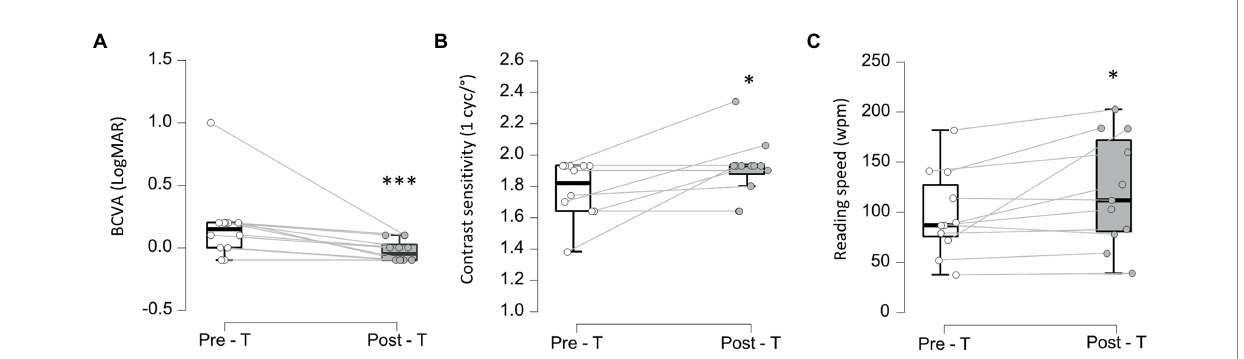
FIGURE 3 Visual acuity, contrast sensitivity and reding speed. (A-C) Pre (Pre-T) and post-treatment (Post-T) measures of visual acuity using Best Corrected Visual Acuity (BCVA) (A) ***BF -0 > 10, contrast sensitivity at 1cyc/ ° (B) and reading speed (in words per minute—wpm) (C) *BF +0 >